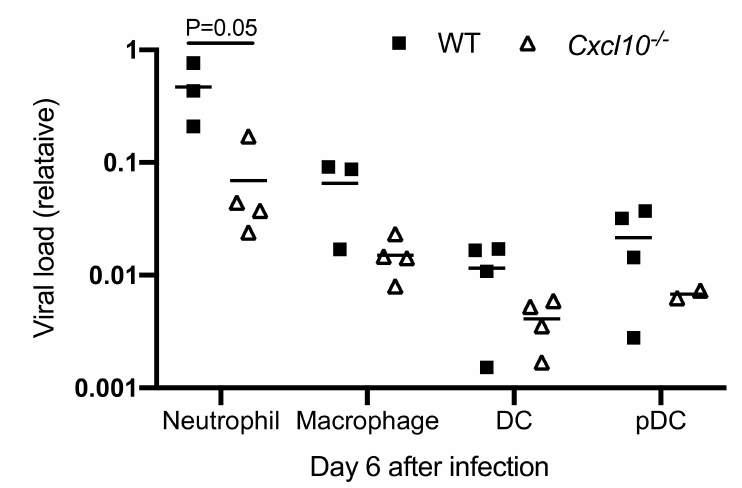
Figure 5. Viral RNA loads are reduced in Cxcl10 − / − macrophages and neutrophils. Age- and sex-matched C57BL / 6 (WT) and Cxcl10-deficient ( Cxcl10 − / − ) mice were infected with ONNV. Immune cells were sorted by FACS. ONNV RNA in the sorted immune cells was quantitated by RT-PCR. Each dot = one mouse. The horizontal line in each column = the median. p values were calculated with the Mann-Whitney